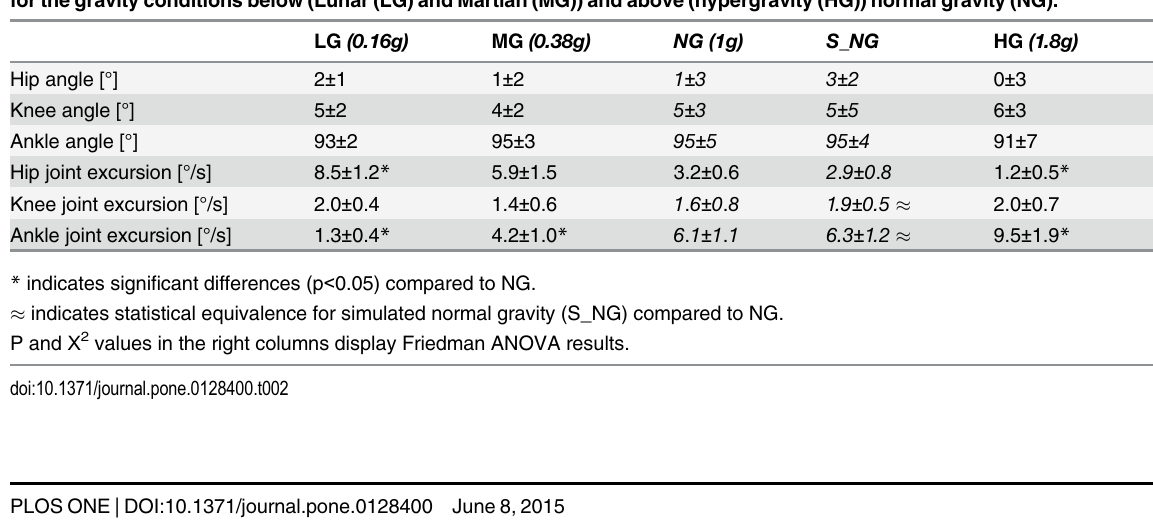
Table 2. Averaged values of all participants for the mean ankle, knee and hip angles (top) as well as the corresponding joint excursions (bottom) for the gravity conditions below (Lunar (LG) and Martian (MG)) and above (hypergravity (HG)) normal gravity (NG).